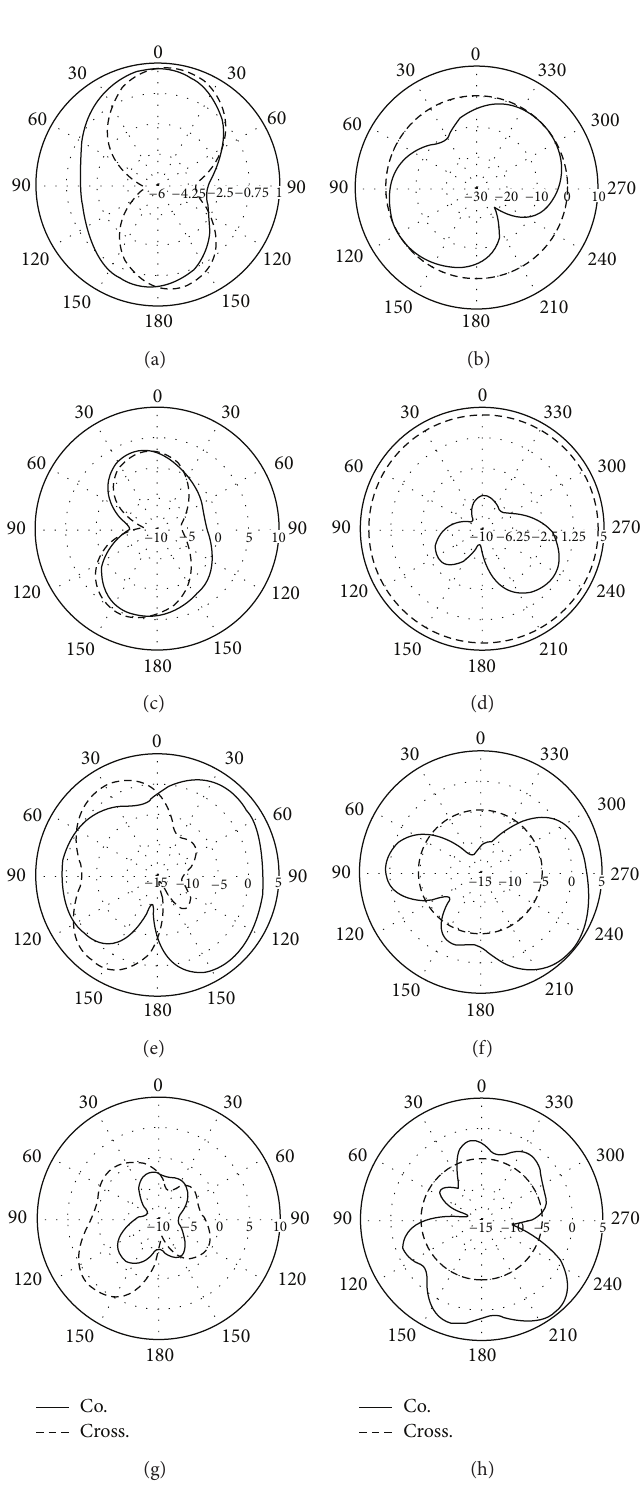
Figure 12: Measured E-plane (a, c, e, and g) and H-plane (b, d, f, and h) of the proposed antenna: (a, b) 3.17GHz, (c, d) 7.32 GHz, (e, f) 9.97 GHz, and (g, h) 12.16